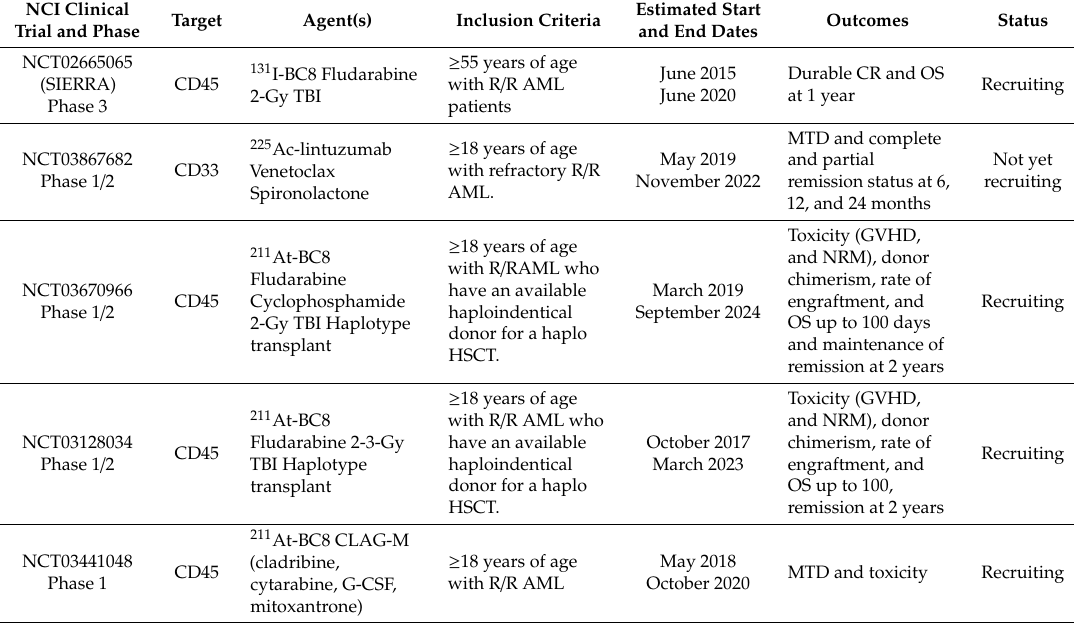
Table 4. Clinical trials of RIT for